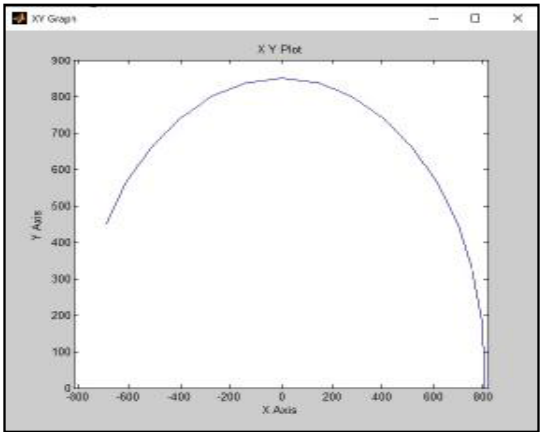
Fig. 14. Tthe Desired First